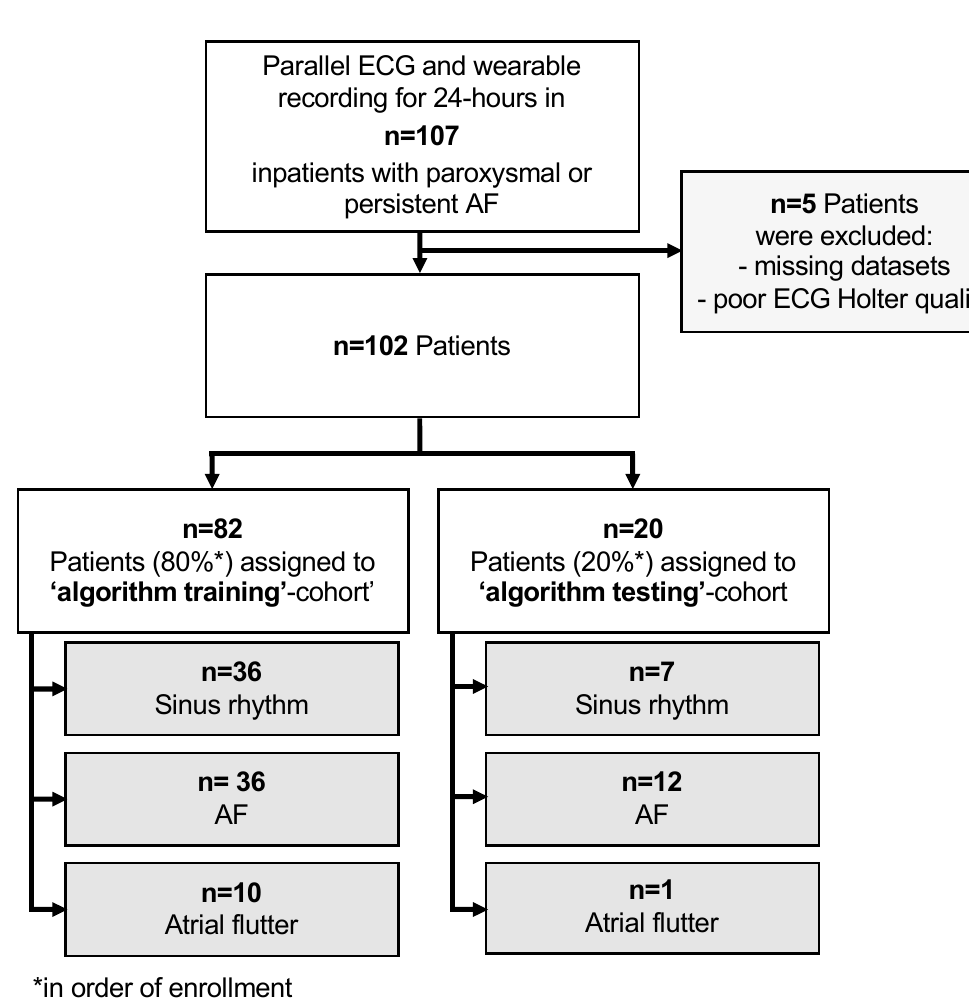
Figure 1. Flow-chart of patient disposition for algorithm development and group classification for the trial.